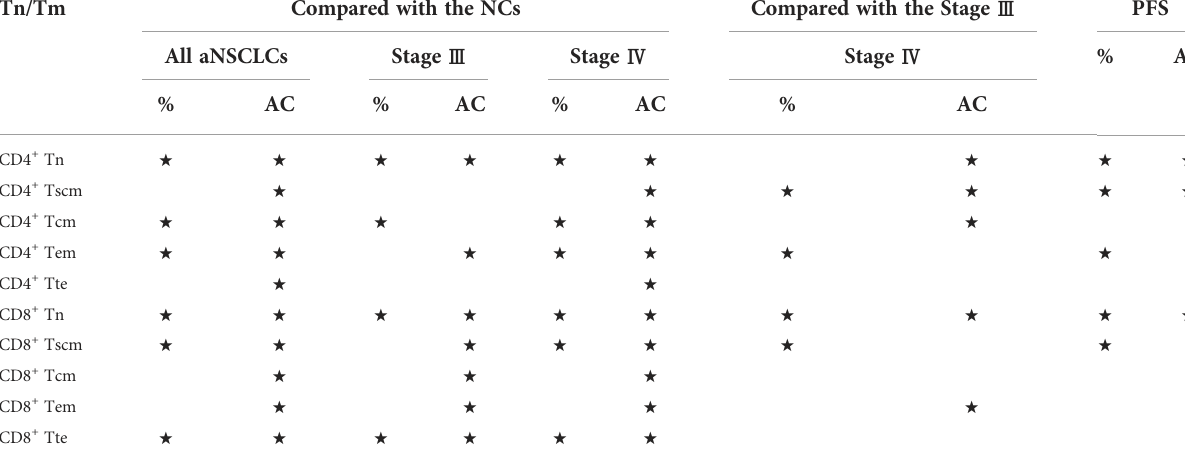
TABLE 2 Cells impairment and prognostic cells in aNSCLCs.